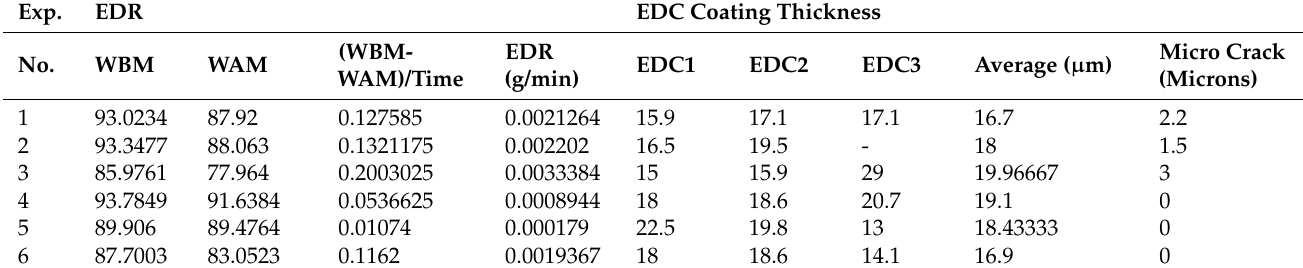
Table 4. Output parameters.